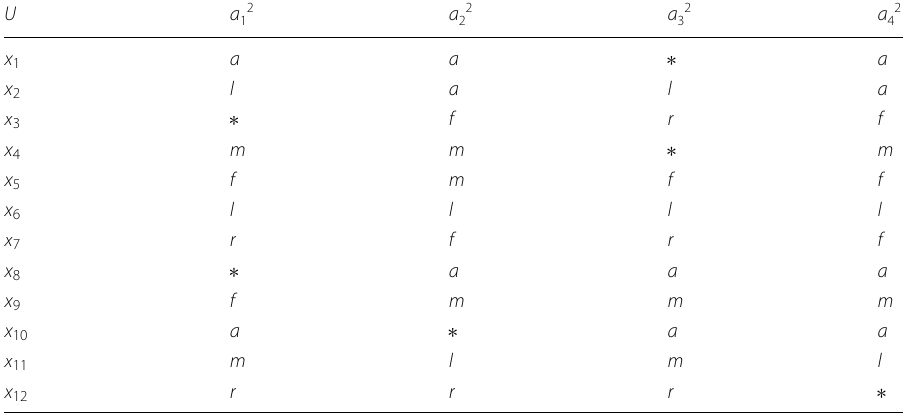
Table 3 The incomplete ordered information table with the second level of granulations